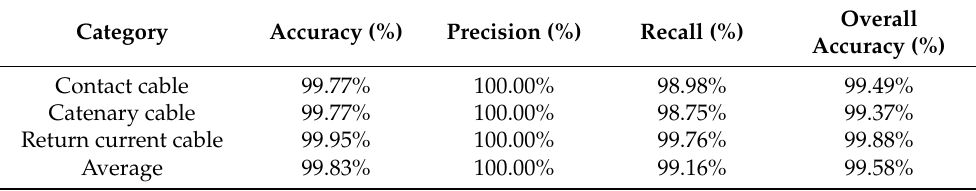
Table 3. Accuracy evaluation index of classification results of the 50 m OCS point cloud.